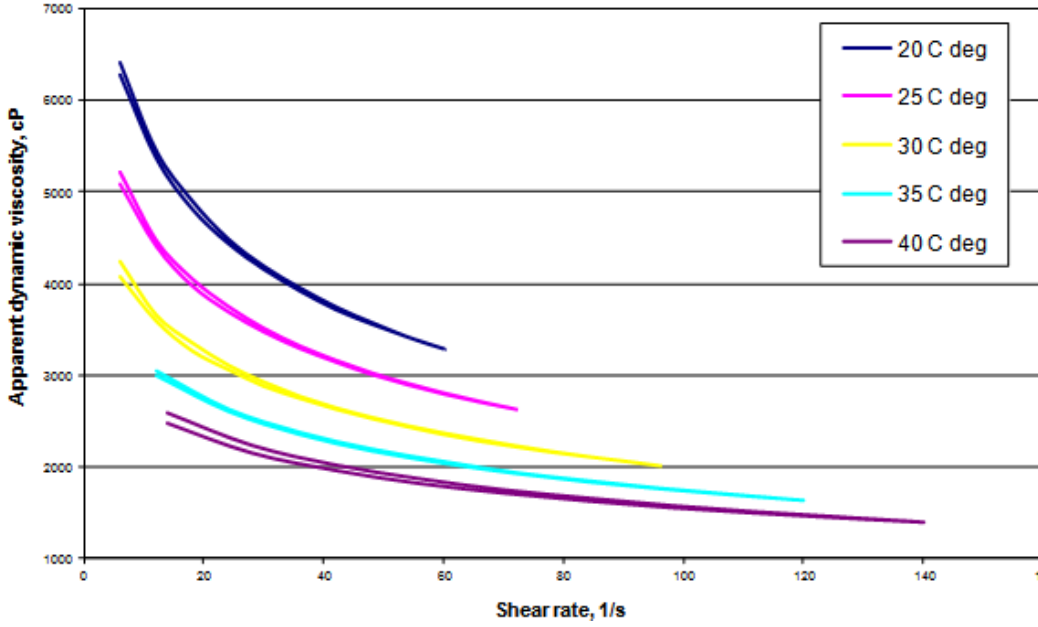
Figure 2. Dependence of the apparent dynamic viscosity on the shearing rate and temperature of the acetate chitosan solution modified with HAp/ β -TCP (MCT